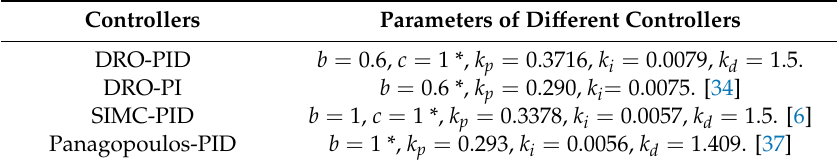
Table 7. Parameters of di ff erent controllers for Example